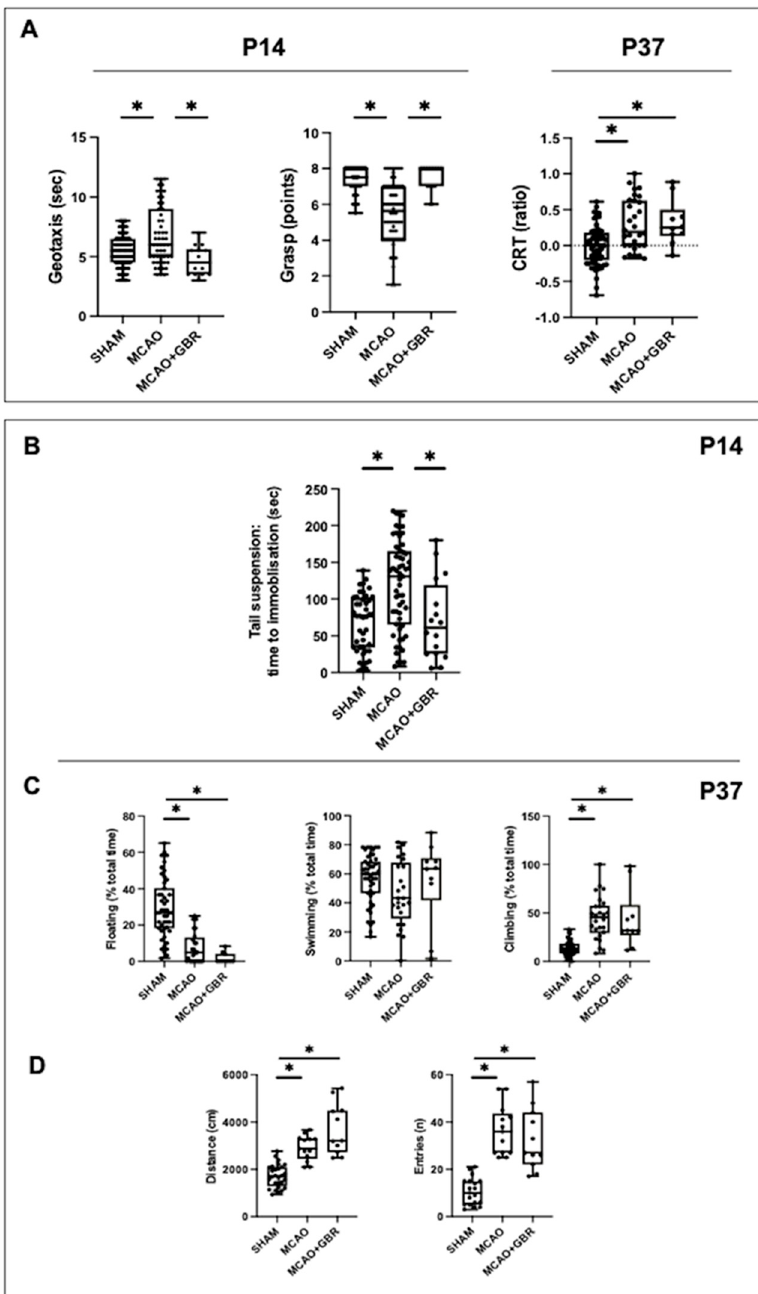
Figure 4. Assessment of functional deficits and mood disorders in rats submitted to MCAO at seven days of life (P7) and then treated with vehicle (MCAO) or the DA reuptake inhibitor GBR12909 (MCAO + GBR) and the corresponding healthy controls (SHAM). ( A ) Functional consequences of MCAO measured in the medium (P14) and long terms (P37). ( B ) Quantification of immobilization time in the tails suspension test, performed at P14. At P37, quantification of ( C ) floating, swimming and climbing time in the forced swimming test, and ( D ) distance traveled and number of entries to the center of the arena in the open field test. Boxes represent the median and the interquartile range, whereas whiskers represent the minimum and maximum values in each group. CRT: cylinder rear test. (*) p < 0.05 by Kruskal − Wallis test with Dunn’s test for multiple comparisons: ( A ): Geotaxis: W = 15, p = 0.0005; Grasp: W = 61, p < 0.0001; CRT: W = 170, p = 0.0001; ( C ): U = 0, p = 0.0002. ( B ): W = 19, p < 0.0001; ( C ): Floating: W = 44, p < 0.0001; Swimming: W = 3, p = 0.18; Climbing: W = 39, p < 0.0001; ( D ): Distance : W = 33, p < 0.0001; Entries : W = 30, p < 0.0001.